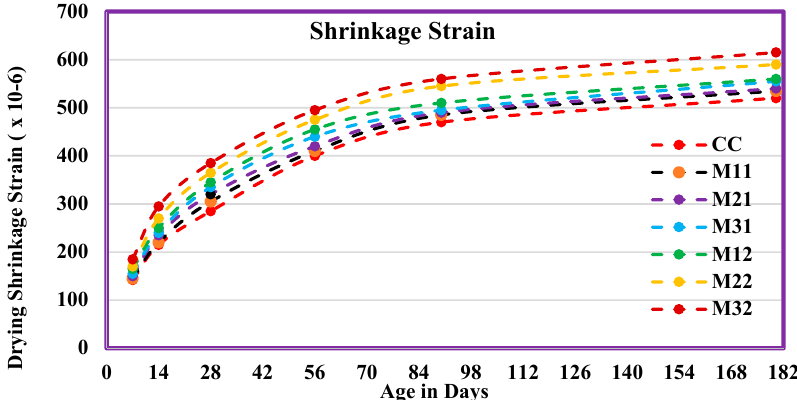
Figure 14. Drying shrinkage strain contains different percentages of FS and CS.